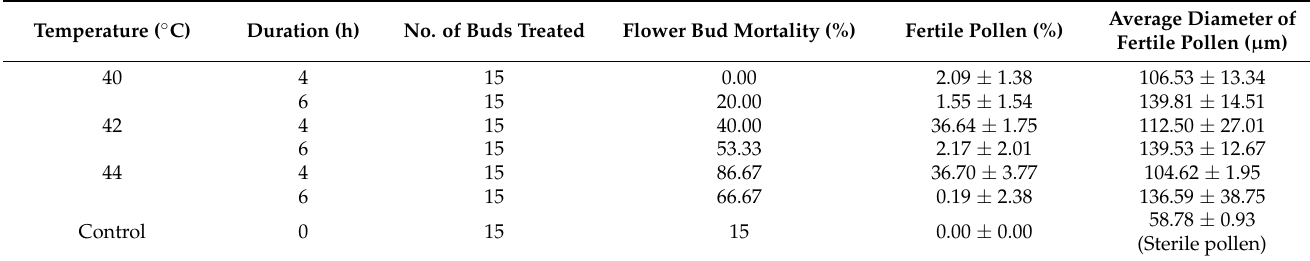
Table 2. Effects of different high temperatures and durations on buds and fertile pollens of ‘Black Beauty’. Temperature ( ◦ C)